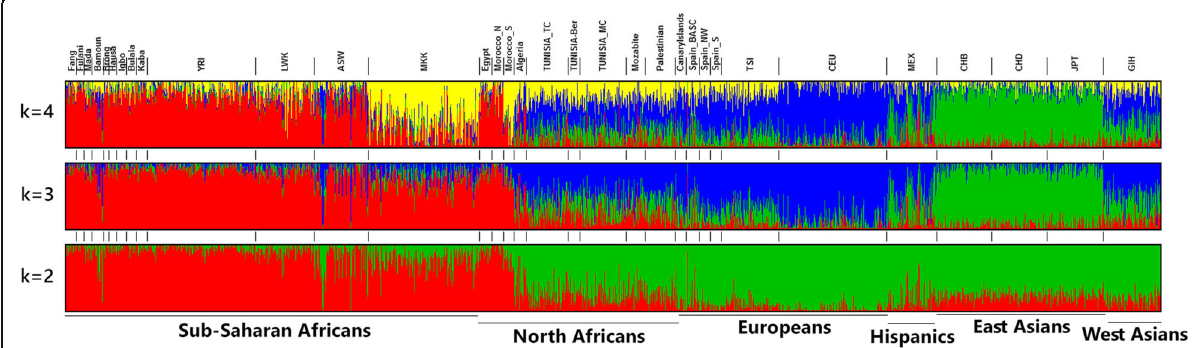
Fig. 2 Ancestry proportions at K = 2 to K = 4 estimated by means of ADMIXTURE clustering analysis performed on the extended LP-related region. Population structure of worldwide human populations is shown for 1677 individuals from 33 different groups globally distributed (from left to right: 633 Sub-Saharan Africans, 225 North Africans, 399 Europeans, 77 Mexicans, 255 East Asians, 88